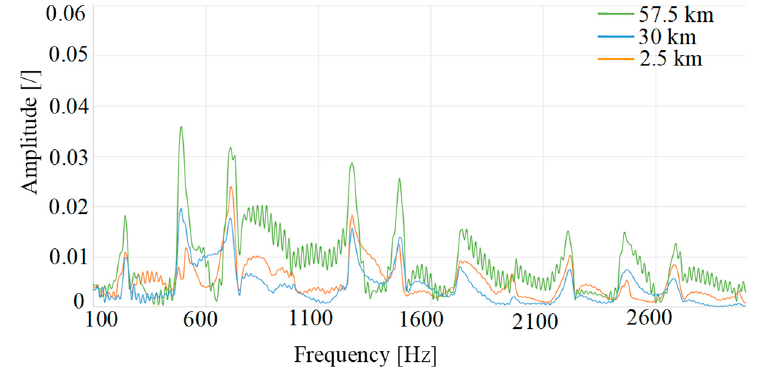
Figure 11. Transient current frequency spectra for different fault distances.